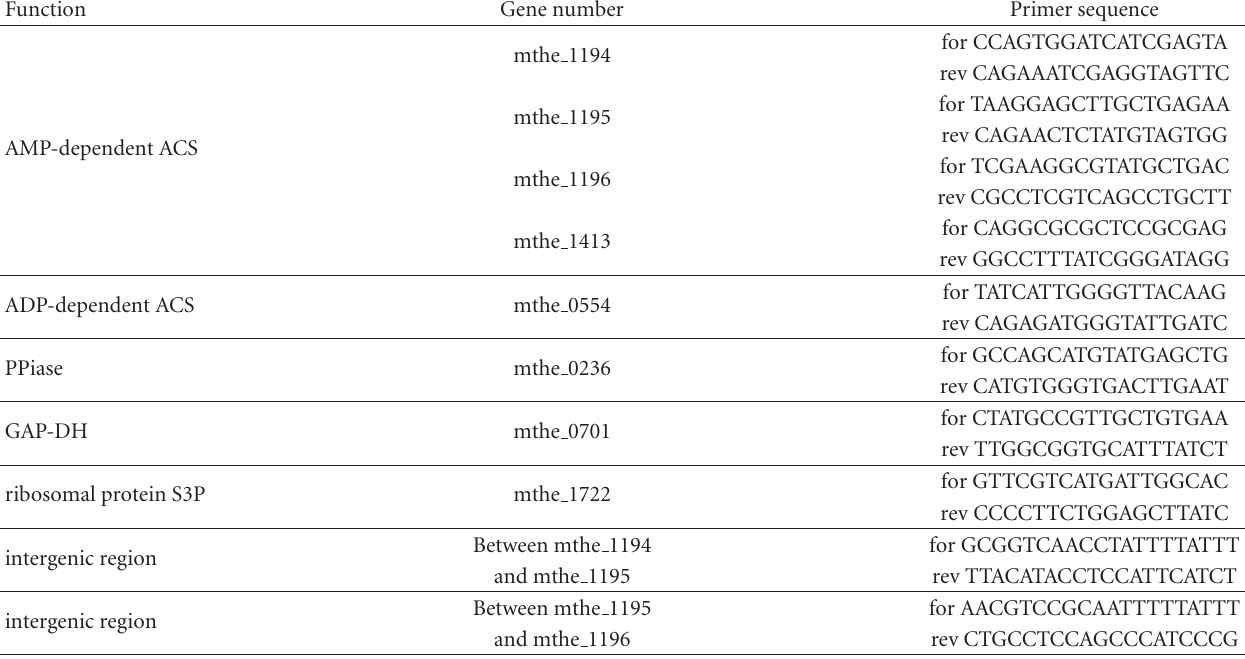
Table 1: Gene number, function of corresponding protein and primers used for amplification of genes analyzed by qRT-PCR.